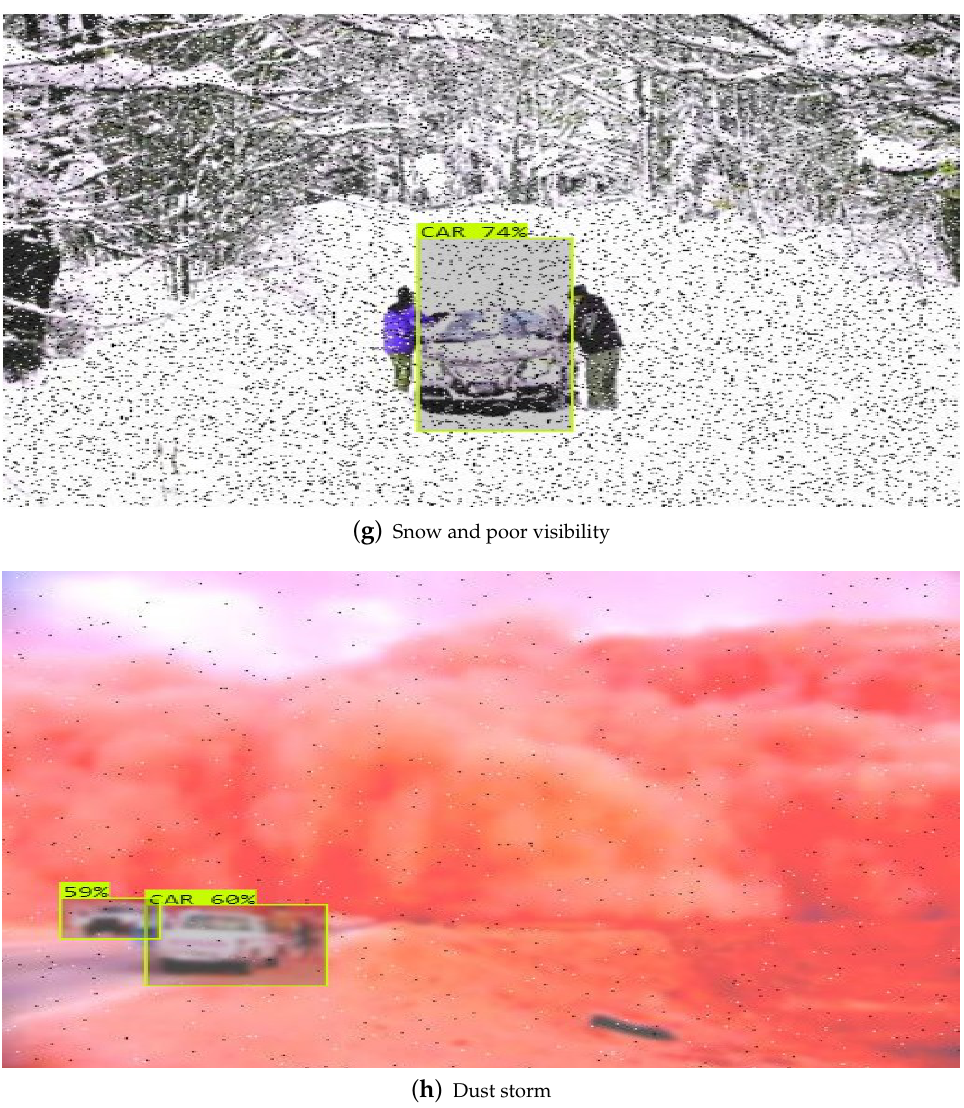
Figure 15. Sample images tested with confidence